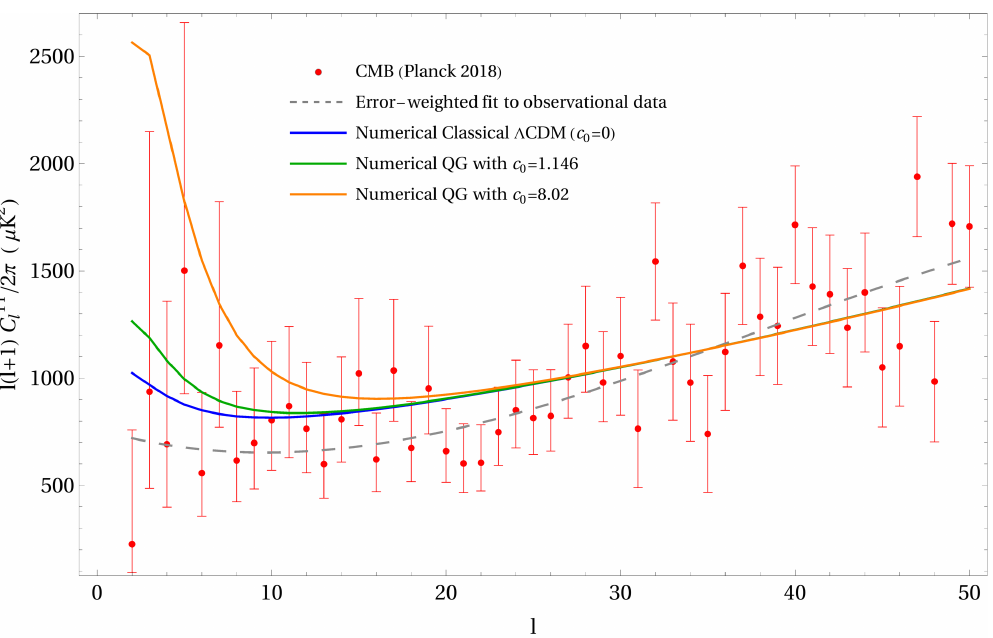
Figure 4. Comparison of the numerical prediction of the classical Λ CDM program vs. the numerical predictions of the renormalization group (RG) running of Newton’s constant’s effect on the temperature (TT) power spectrum C TT . The solid curves represent the numerical predictions generated by the l ISiTGR program, with the bottom (blue), middle (green) and top (orange) representing quantum amplitudes (see Equation (9)) c 0 = 0,1.146,8.02, respectively (see Equation (9)), showing a higher trend at large angular scales ( l < 20) as compared to the classical Λ CDM (no running) numerical curve. The dashed curve represents an error-weighted cubic fit to the observational CMB data, from the Planck (2018) collaboration